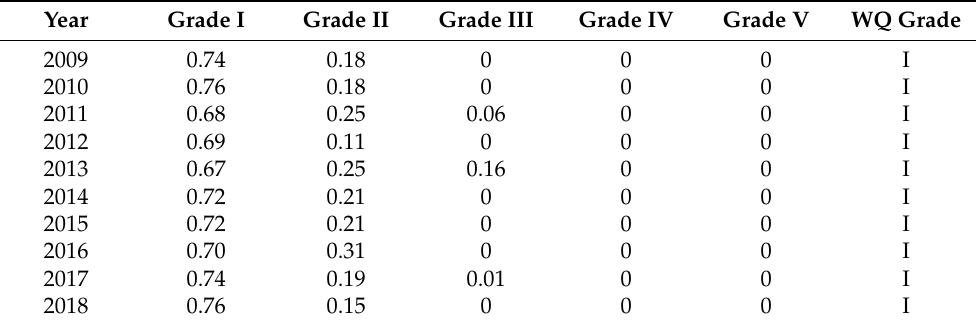
Table A12. Fuzzy integrated evaluation results of Xishan Station in Suzhou, Jiangsu.